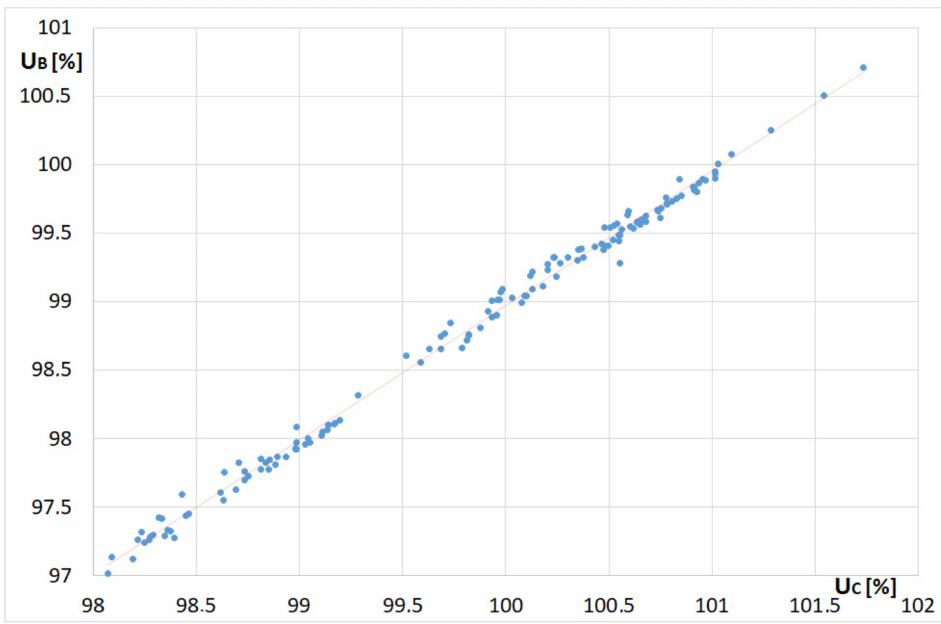
Figure 20. Correlation between voltage changes recorded at points B and